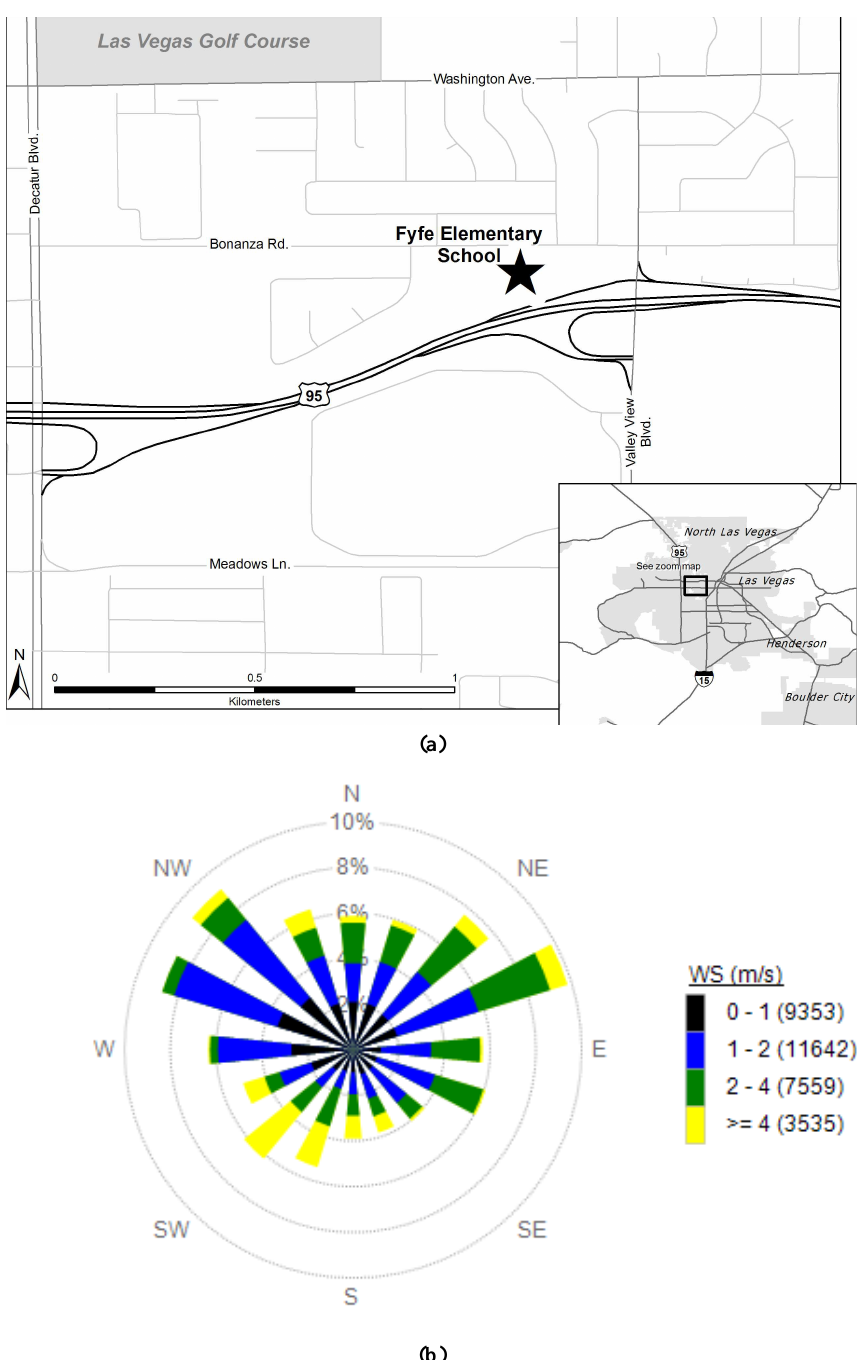
Fig. 1. (a) location of Fyfe Elementary School in Las Vegas, Nevada; and (b) wind rose for January 2008 (5-min averages).